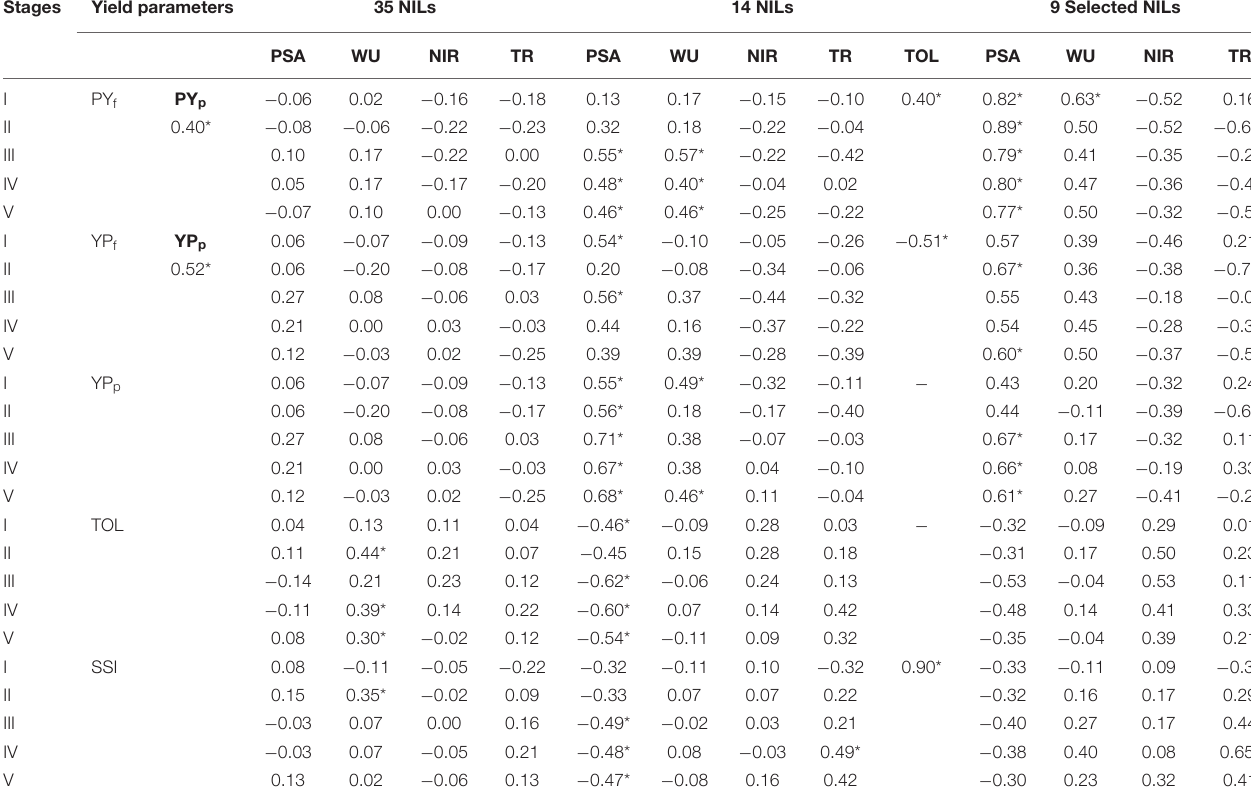
TABLE 5 | Correlations between grain yield, phenomics parameters, and major tolerance indices among the selected NILs. Stages Yield parameters 35